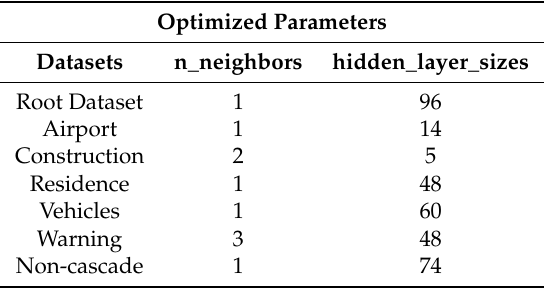
Table 9. The parameters for the optimization of the k-NN and ANN classifiers for the datasets of the cascade approach and for the non-cascade approach.